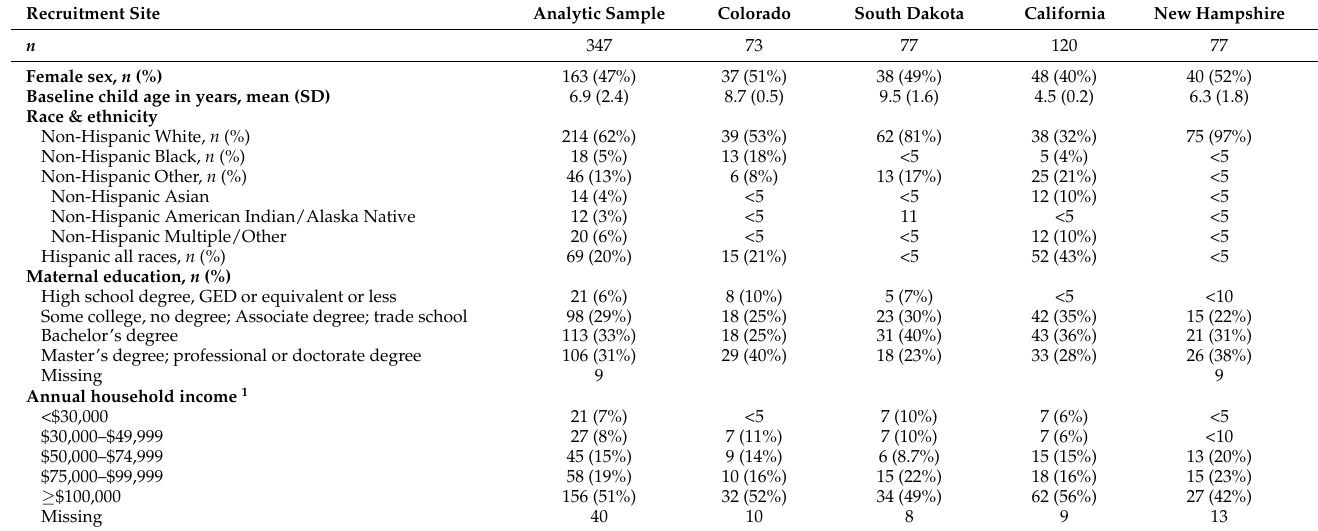
Table 1. Descriptive characteristics of the analytic sample among children ages 4–12 years in 4 cohorts participating in the Environmental influences on Child Health Outcomes (ECHO) Program.